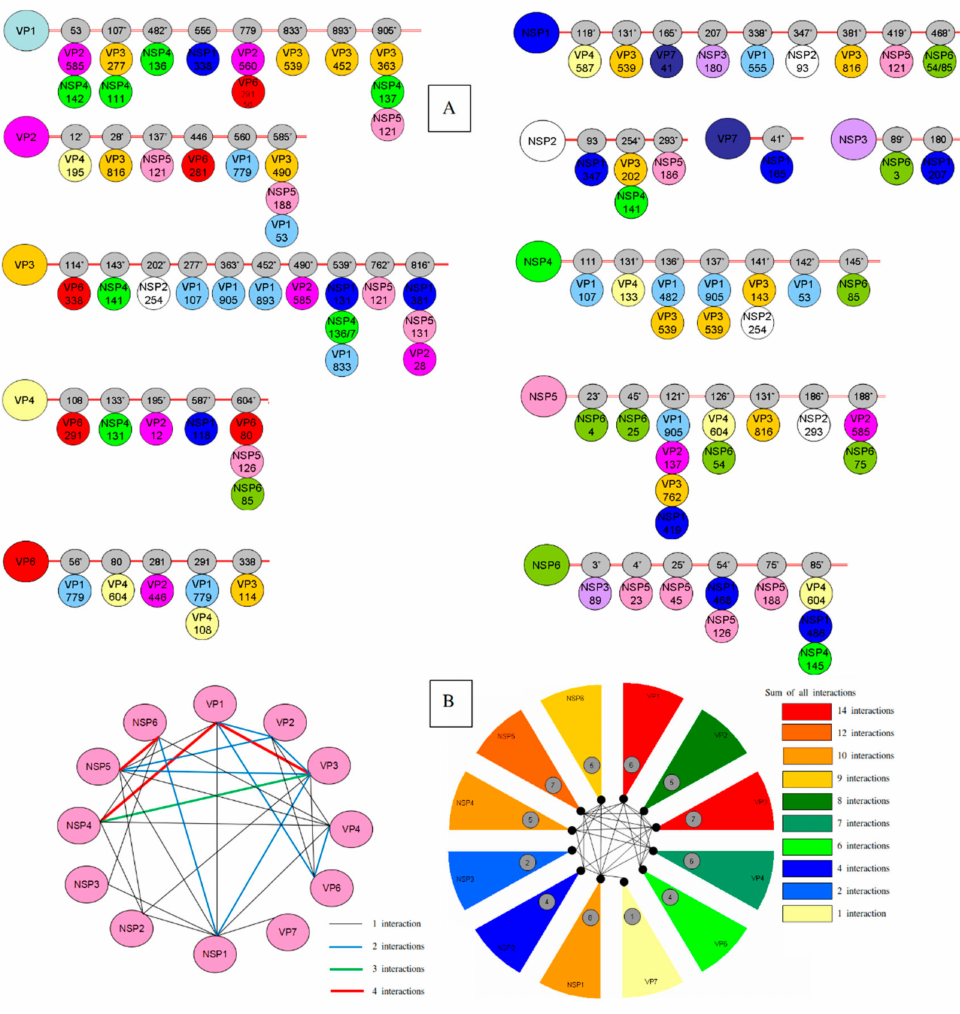
Figure 1. Coevolutionary analysis of Rotavirus A (RVA) proteins. ( A ) Linear representation of intermolecular connection. Each viral protein is represented by a circle and residue position with a defined color. Grey circles on the horizontal lines represent the positions of coevolving residues. dN / dS ratios of > 1 is represented by stars. ( B ) Intermolecular covariation network. Each viral protein is represented by a pink circle. Lines connecting the circles indicate that the two proteins showed intermolecular covarying amino acid positions with posterior probability ≥